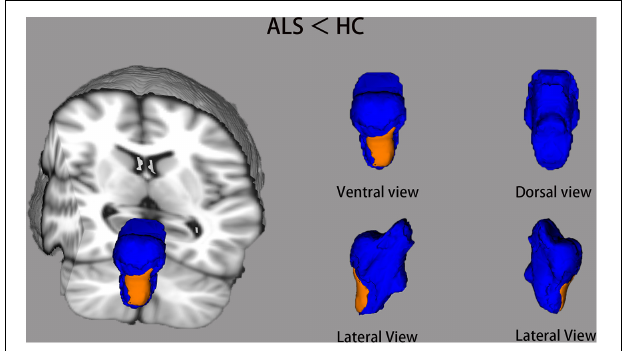
FIGURE 2 | The brainstem shape differences between ALS groups and healthy controls (HC) using vertex-wise surface analyses. The blue color indicates the 3D brainstem mesh. The regions in orange represent ALS-related local shape deformations (ALS < HC). The results are corrected for multiple testing with the threshold-free cluster enhancement (TFCE) and family-wise error (FWE) method ( P <